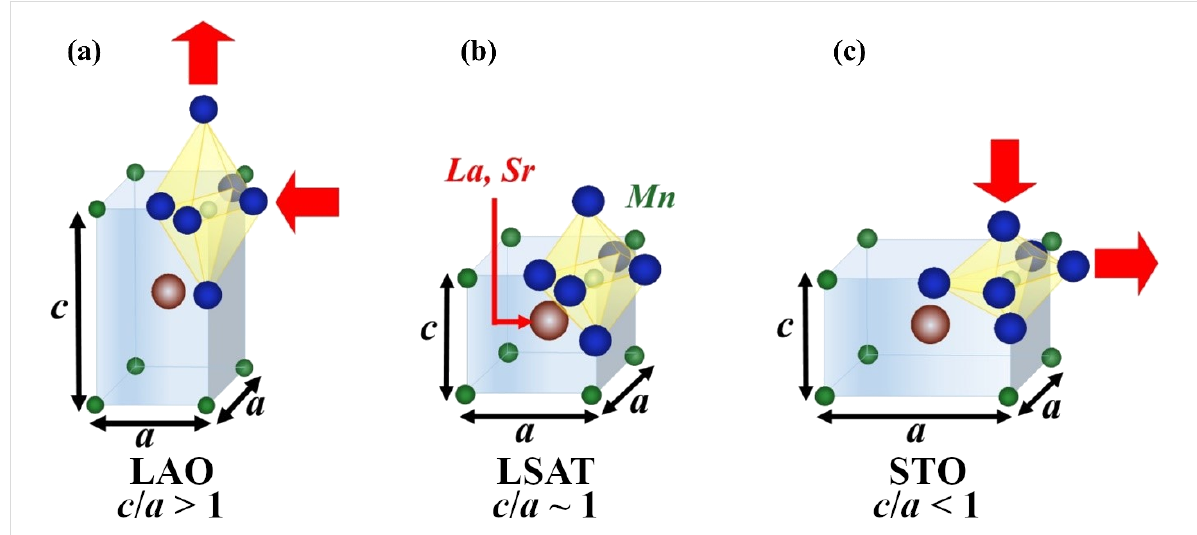
Figure 2: Sketch of lattice distortion of the LSMO crystal cell induced by the substrate: (a) compressive–strain deformation on LAO, (b) nearly unstrained growth on LSAT, and (c) tensile-strained deformation on STO.